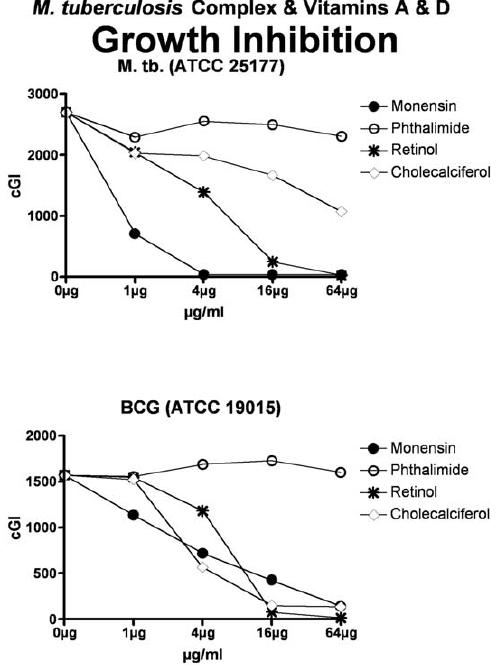
Figure 3. Both vitamins A & D inhibit the M.tb complex. Vitamin D is less effective against M. tb ATCC 25177. The inhibitory control is Monensin, and the non-inhibitory control is Phthalimide. cGI=cumu- lative Growth Index.